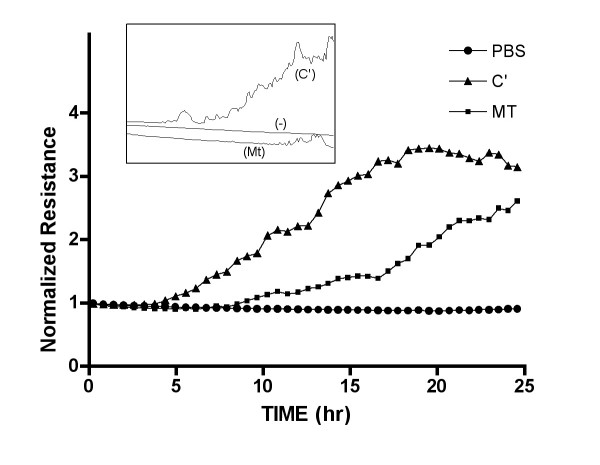
ECIS/taxis assessment of the chemotactic response by WBC 264-9C cells. Cell wells were loaded and guinea pig serum (1:2 dilution), PBS, or 20 μM metallothionein was added to the chemoattractant wells. Serum complement is activated by exposure to agarose to generate a control chemotactic gradient. Inset: A 3 hours window of data on an expanded scale showing the arrival of cells on the electrode.